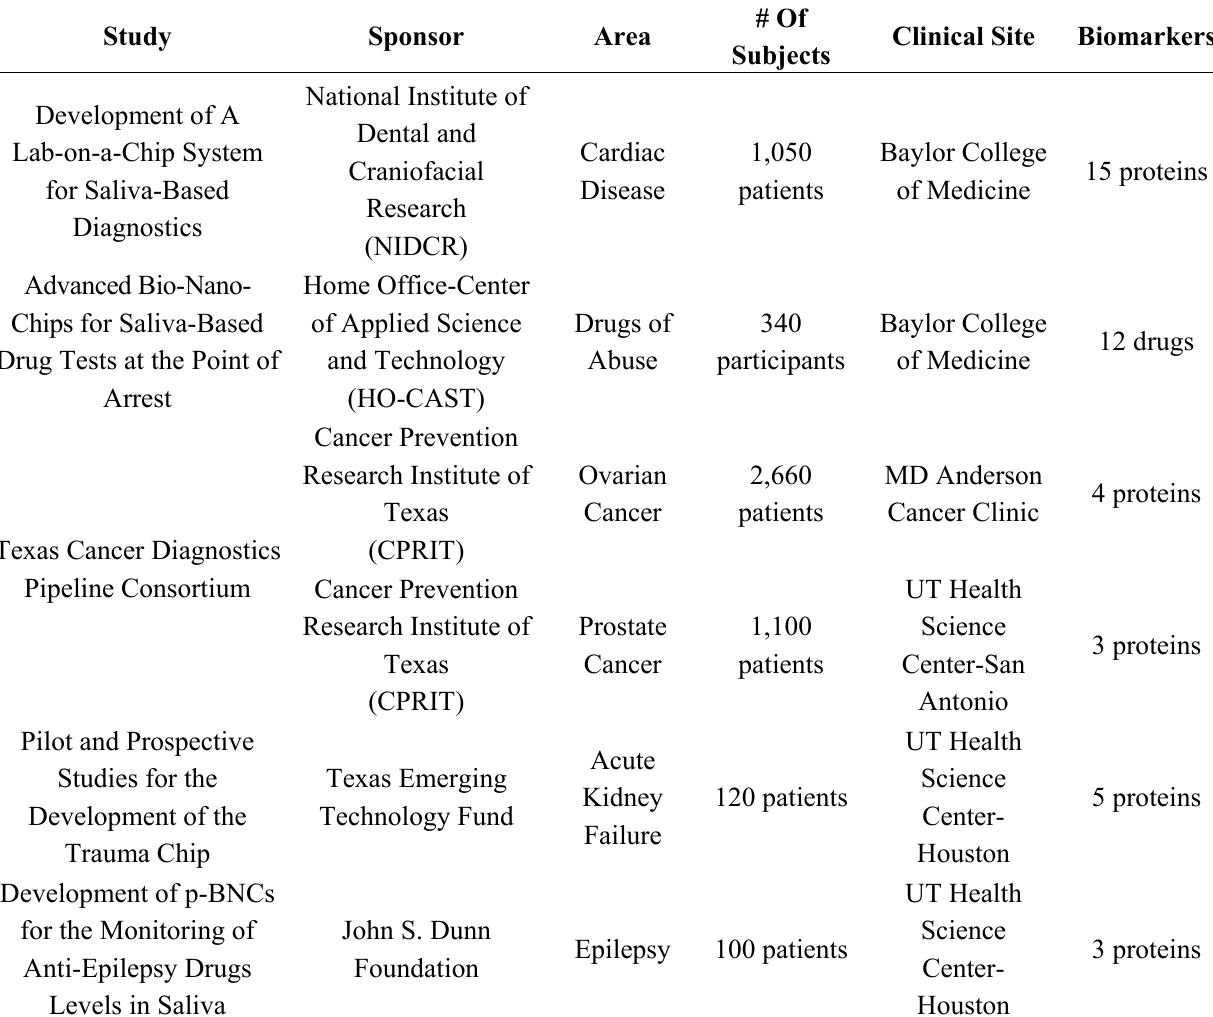
Table 1. The bead-based p-BNC is involved in six clinical trials through several major sponsors to target a number of diseases though the validation of a number of